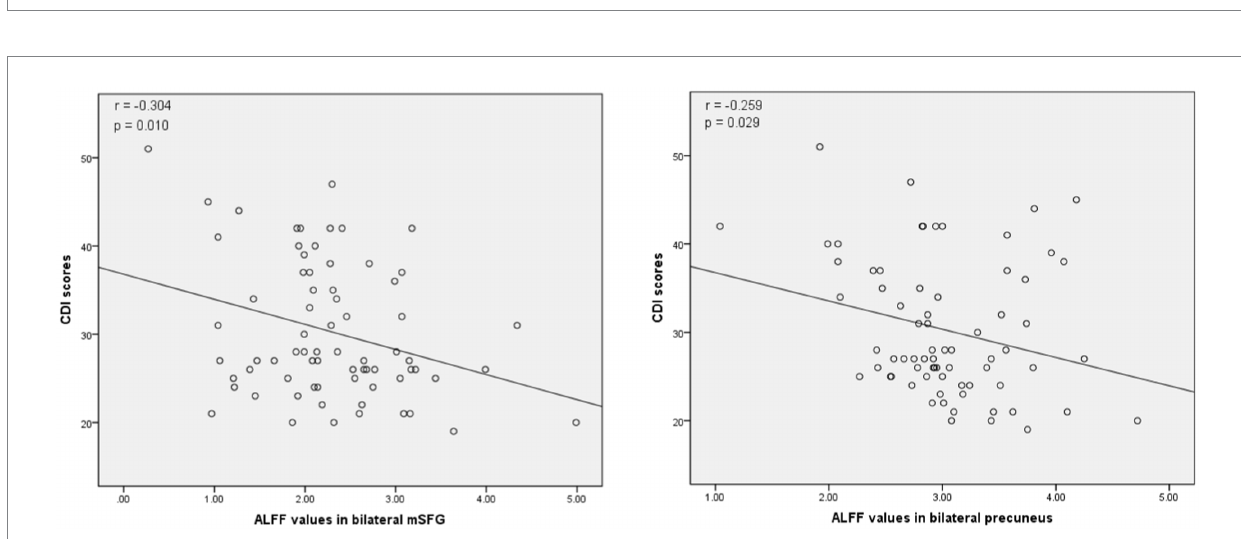
FIGURE 3 Correlations between abnormal ALFF and child depression inventory (CDI) scores. Left: Negative correlation between the ALFF values in the bilateral medial superior frontal gyrus (mSFG) and CDI scores. Right: Negative correlation between the ALFF values in the bilateral precuneus and CDI